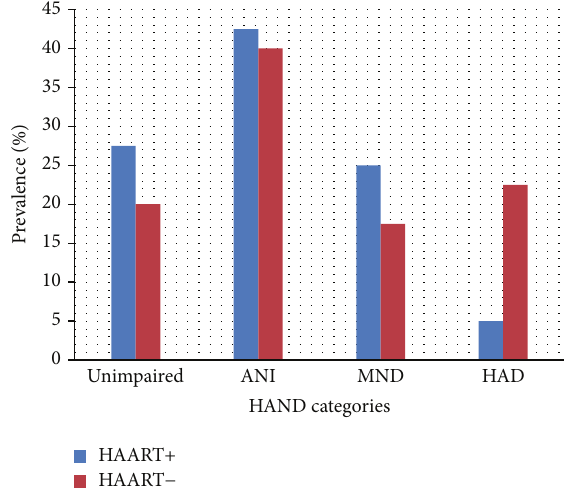
Figure 1: Prevalence of HAND categories among the HIV-positive individuals as defined by Frascati criteria.